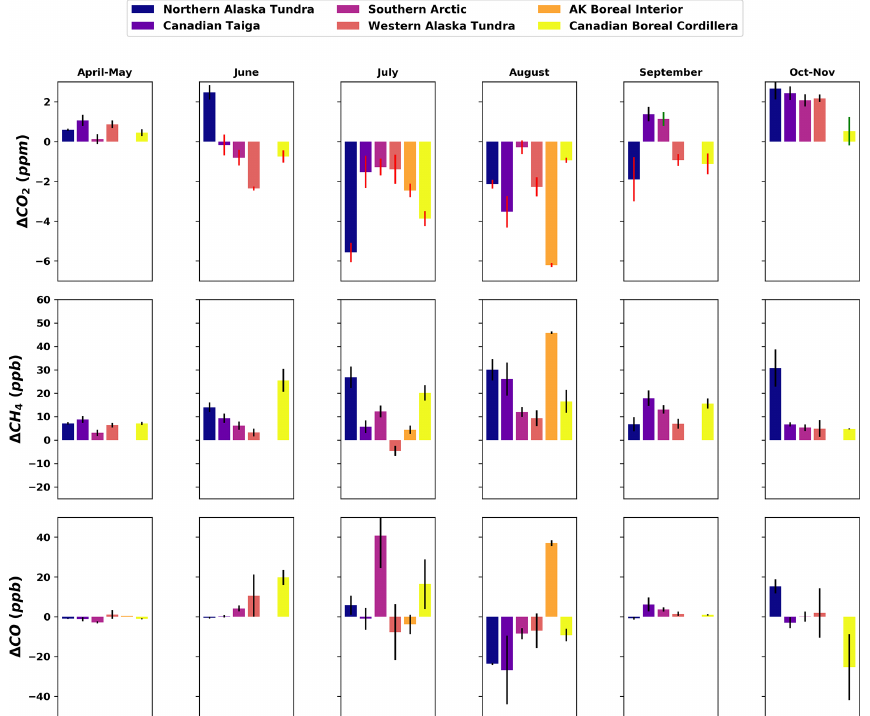
Figure 5. Average gradient between the mean free daily troposphere ( > 3000ma.s.l. for CO 2 and CH 4 and 4000ma.s.l. for CO) and measurements made below 3000ma.s.l. during each campaign. Colors refer to the six ecoregions identified in Fig. 1.